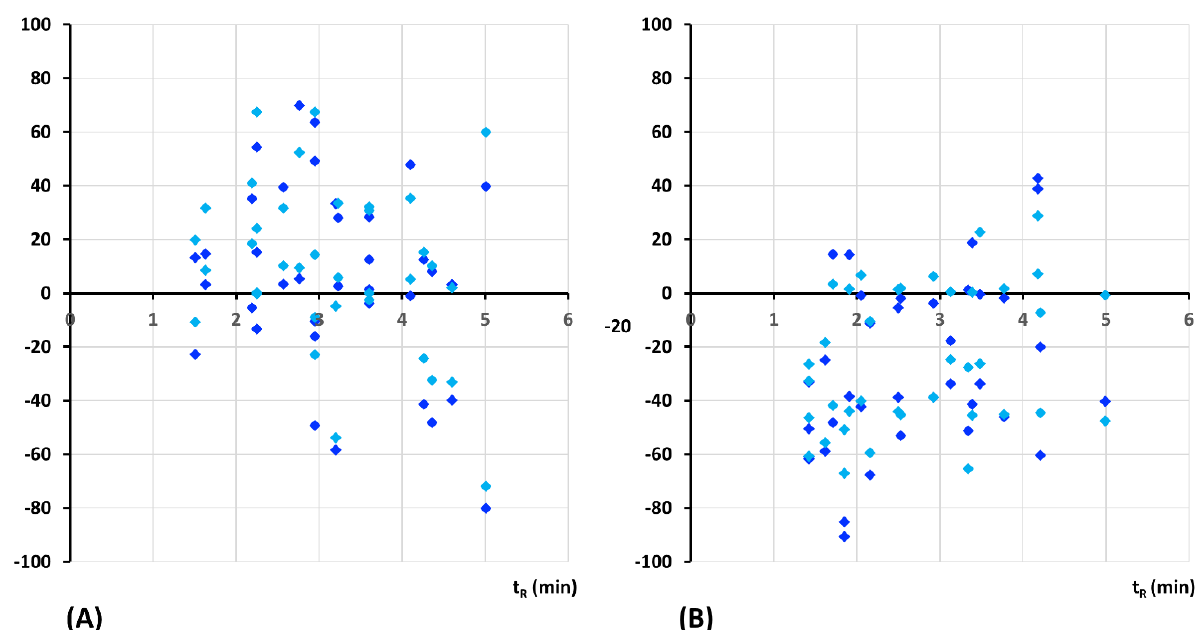
Figure 5. Matrix effects as a function of retention time. Comparison between RP-UHPLC-MS/MS method ( A ) and HILIC- UHPLC-MS/MS method ( B ) at two concentration levels, low QC (dark blue) and high QC (light blue) for HBSS media of pH 6.5 and 7.4.